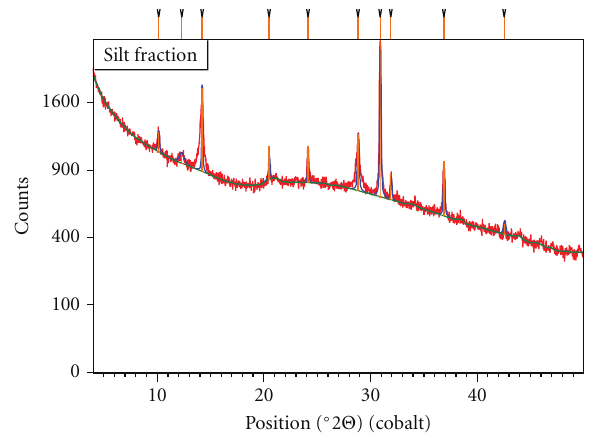
Figure 7: X-ray di ff ractogram of the sediment collected at sampling point 3 (March of